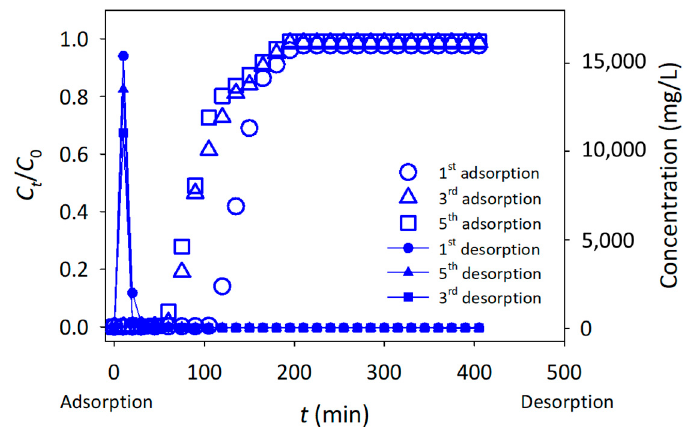
Figure 5. Fixed-bed column regeneration for five cycles of adsorption-desorption.